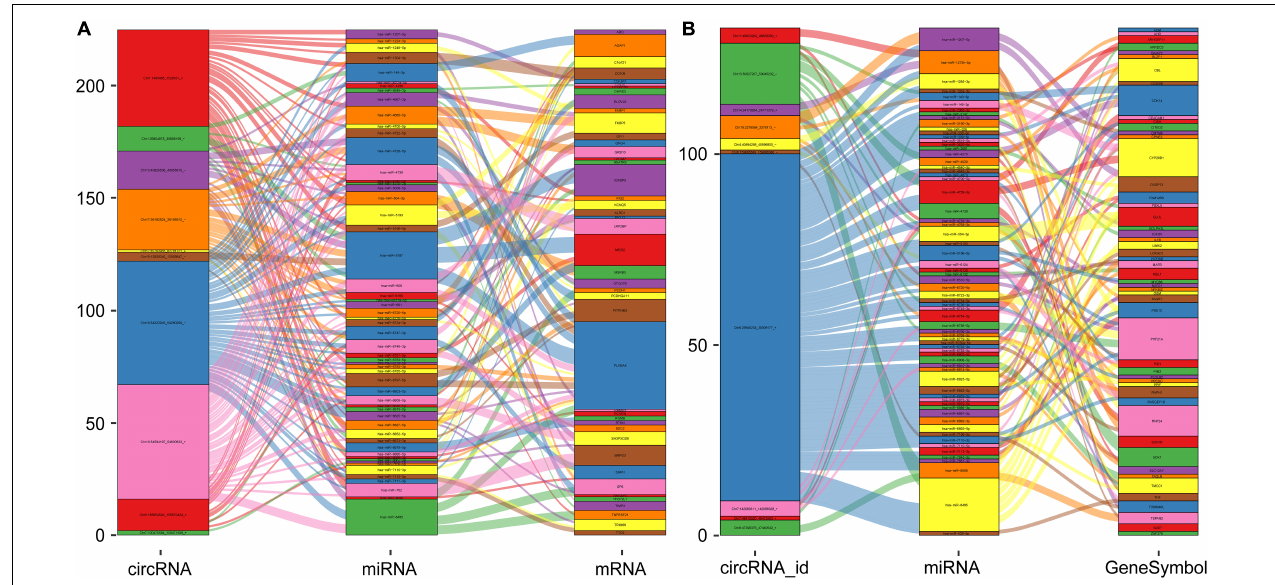
FIGURE 8 | The visualization chart of ceRNA networks. (A) The ceRNA regulatory network of the top 10 downregulated DE-circRNAs. (B) The ceRNA regulatory network of the top 10 upregulated DE-circRNAs. The rectangle represents genes, and the size of the rectangle represents the number of gene